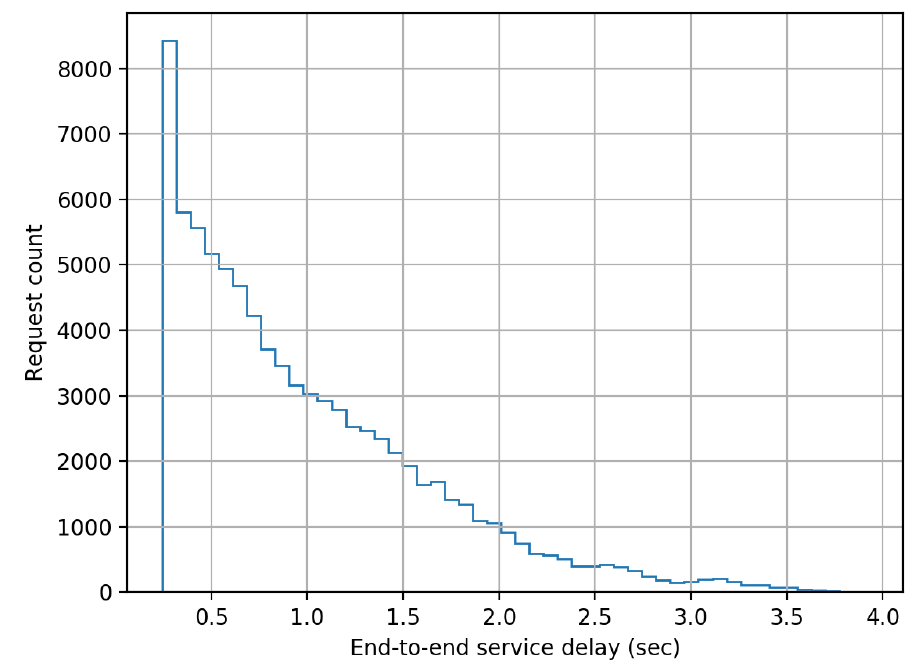
Figure 5. Distribution of end-to-end service delay at a mean request rate of 16 requests-per-second